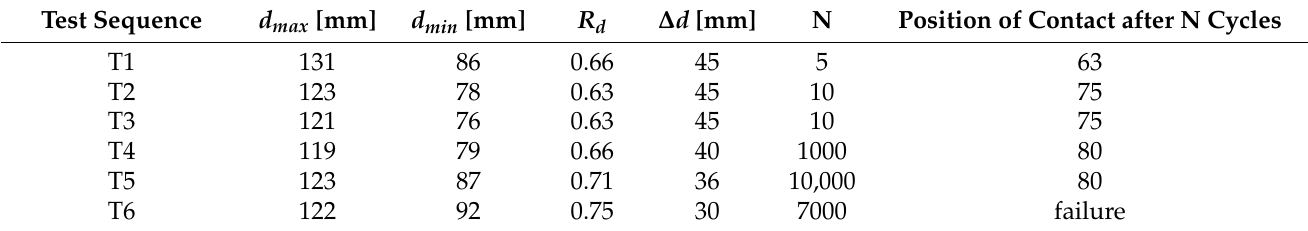
Table 4. Parameters used for the fatigue